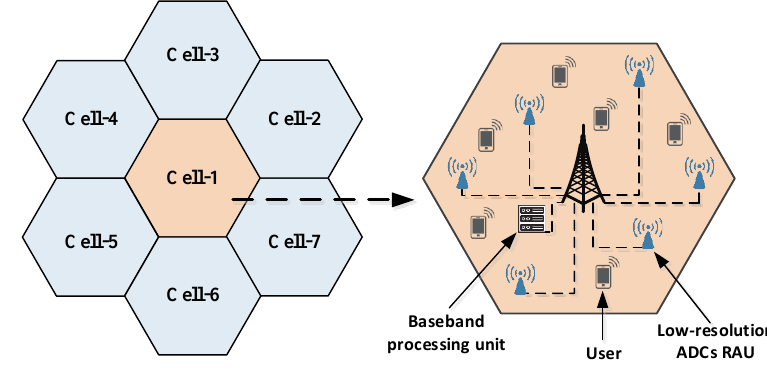
Figure 1. System